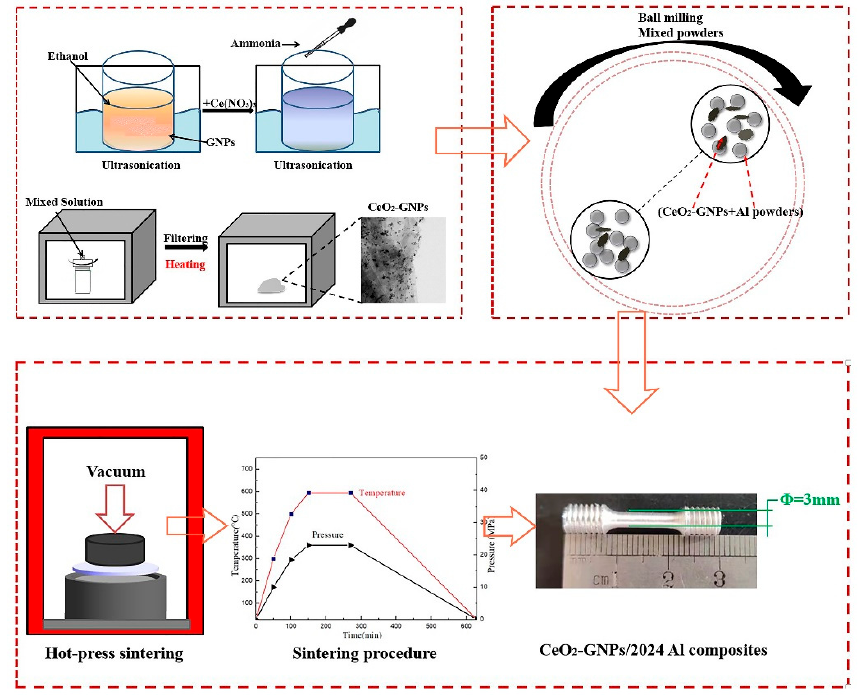
Figure 2. Schematic diagram of the preparation process for GNPs@CeO 2 /2024Al composites. Subsequently, optical microscope (Nikon eclipse, MA-200), environmental scanning electron microscope (Quanta200F EDAX), and transmission electron microscope (TEM, Jeol JEM-2100) were used to observe the microstructure of the prepared composite